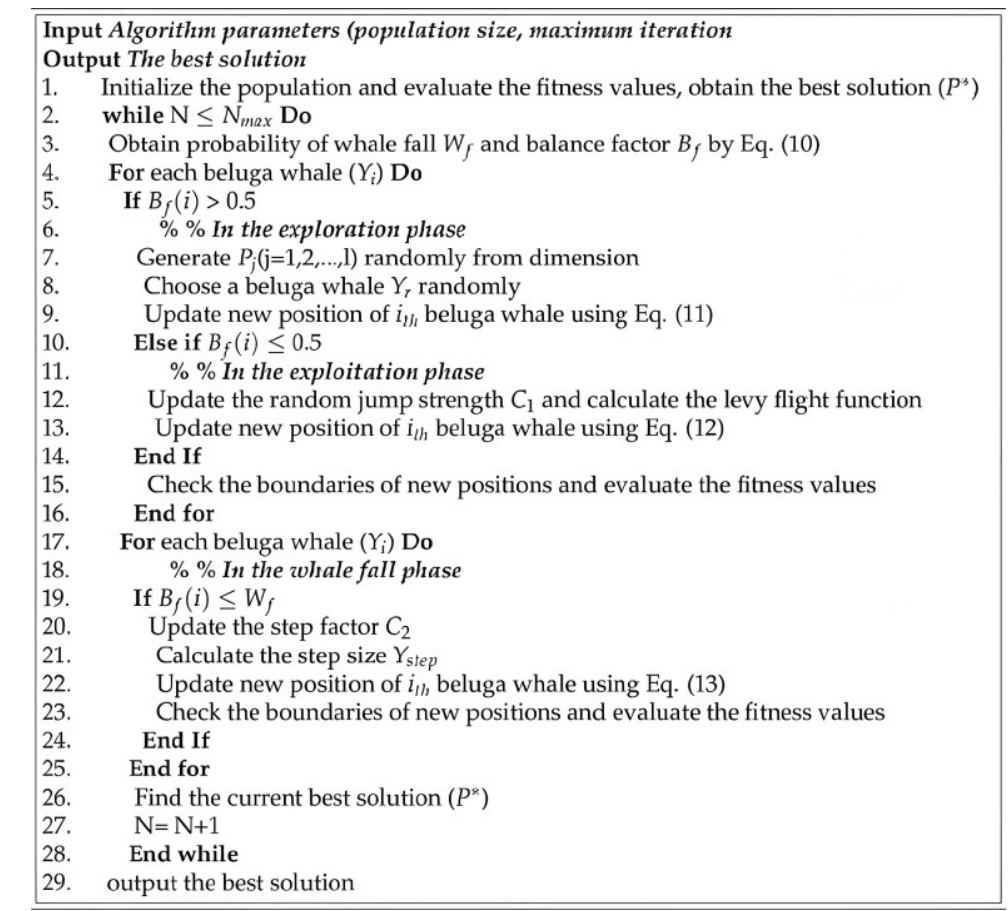
Figure 4. Pseudo-code of BWO